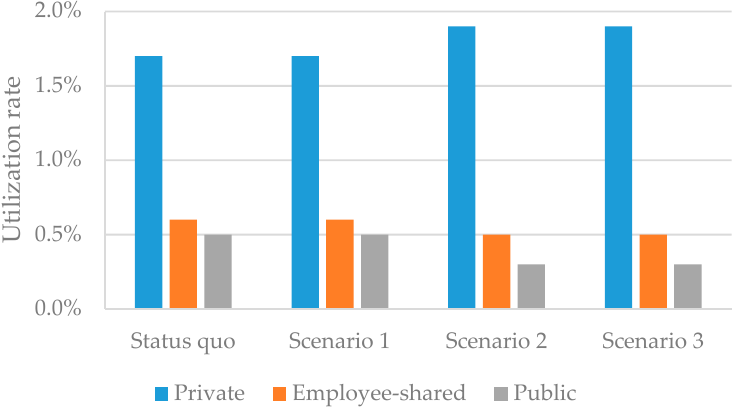
Figure 8. Utilization rate of charging piles in different scenarios.